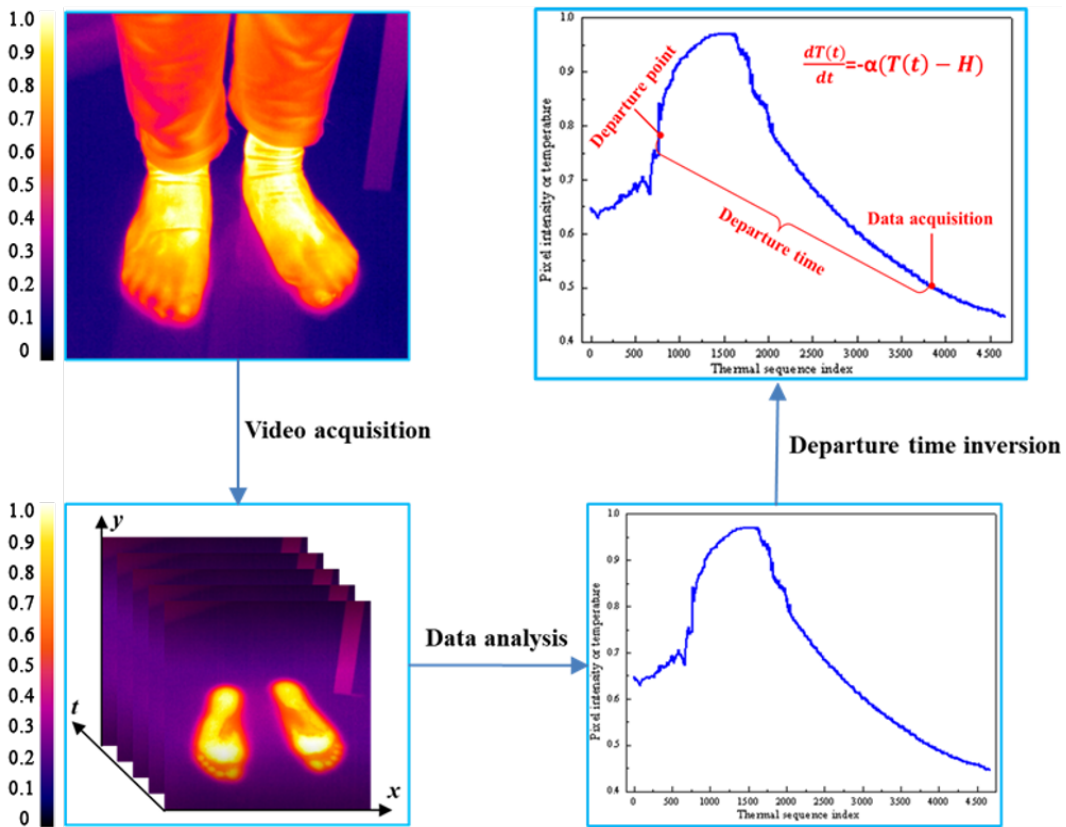
Figure 1. Scheme of departure time estimation. (The pixel values are